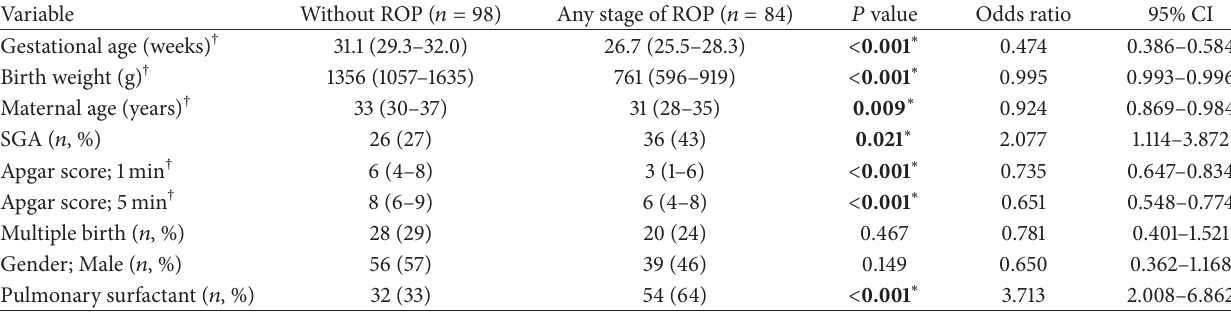
Table 1: Univariate analyses of risk factors for developing any stage of ROP in gestational age < 33 weeks infants. Variable